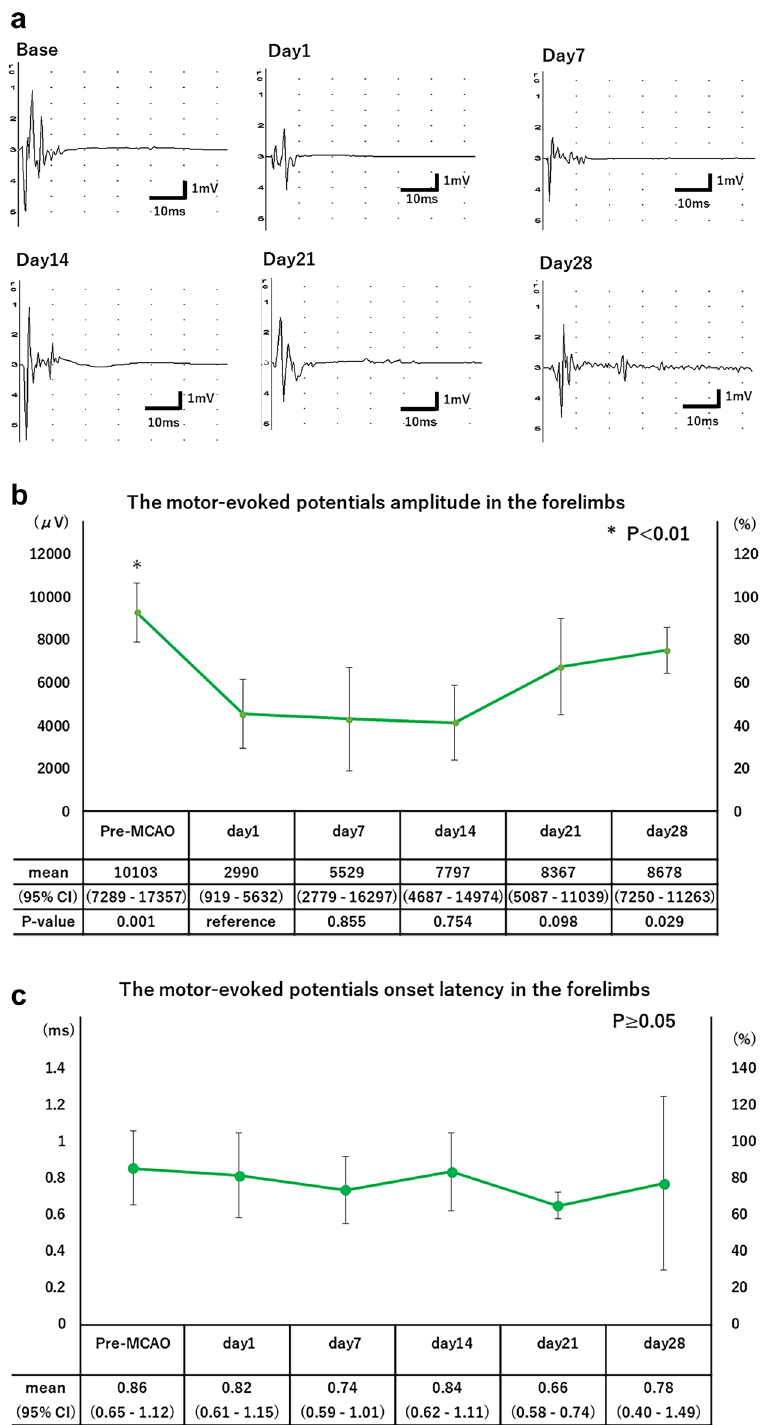
Figure 1. ( a ) Representative recordings of tcMEPs in the forelimbs of rats were plotted before and at 1, 7, 14, 21, and 28 days after the MCAO procedure. ( b ) Time course of the motor evoked potentials amplitude in the forelimbs. The left axis of the table shows the amplitude scale, and the right axis shows the percentage of the amplitude compared to the baseline value. Repeated measures analysis of variance was performed on the weekly measurements. Student-t tests with Bonferroni correction were performed for outcomes with significant one- way analysis of variance. *P < 0.01. ( c ) Time course of the motor evoked potentials onset latency in the forelimbs. The left axis of the table shows the onset latency scale, and the right axis shows the percentage of the onset latency compared to the baseline value. Repeated measures analysis of variance was performed on the weekly